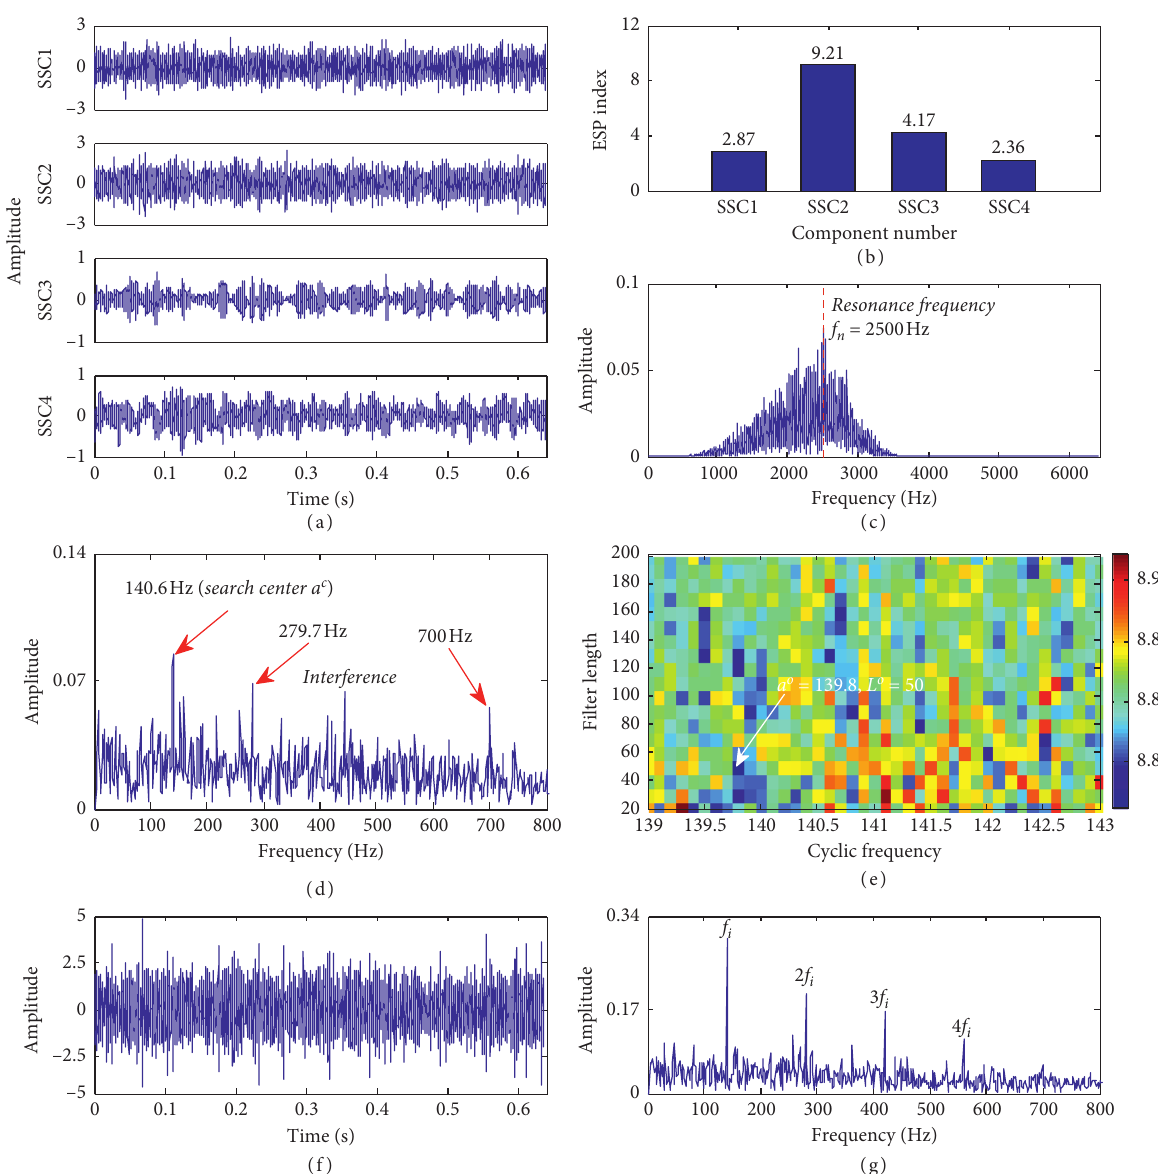
Figure 7: Analysis results of simulated signal by the proposed strategy: (a) the RSSD preprocessing results; (b) the ESP indexes of obtained components; (c) the spectrum of SSC2; (d) the envelope spectrum of SSC2; (e) the grid search result; (f) the waveform of deconvolution signal; (g) the envelope spectrum of deconvolution signal.